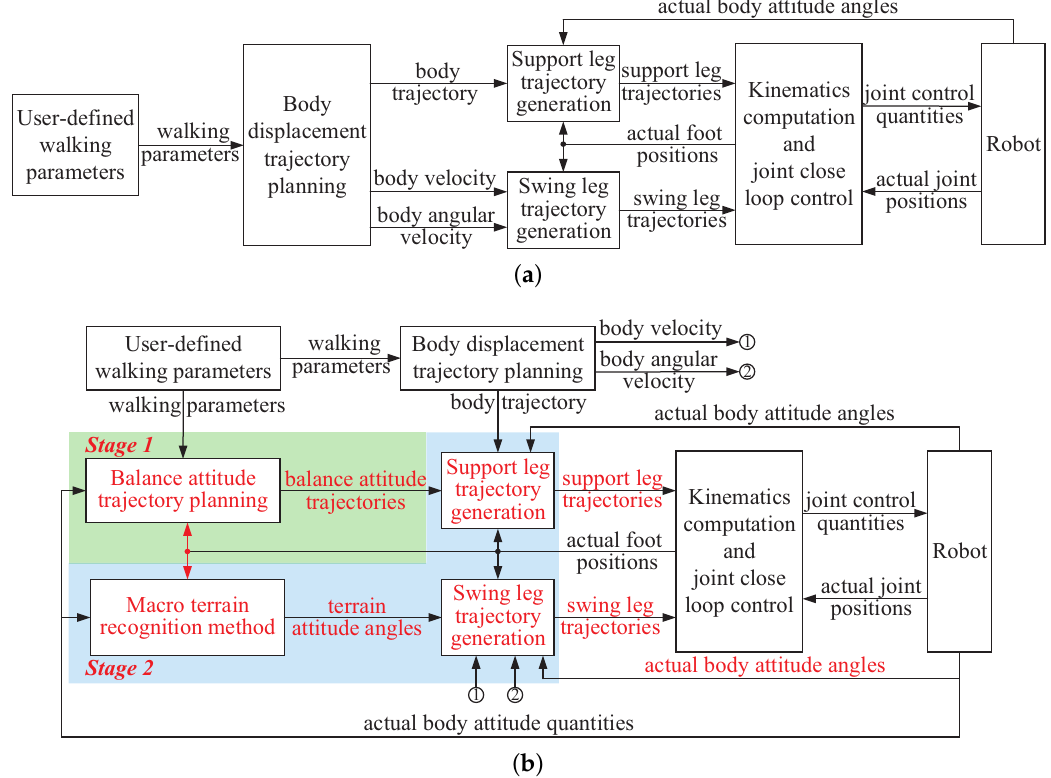
Figure 3. The basic control scheme of a legged robot, and the control scheme of the attitude trajectory optimization method proposed for the large-size hexapod robot: ( a ) the basic control scheme of a legged robot and ( b ) the control scheme of the attitude trajectory optimization method